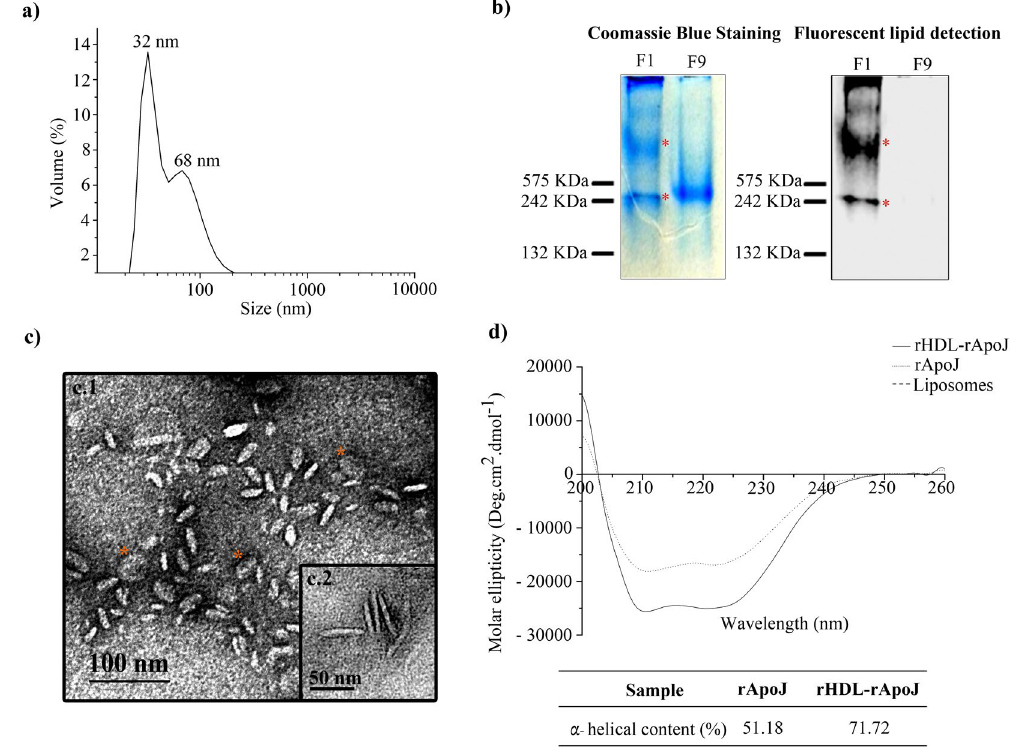
Figure 3. rHDL-rApoJ characterization. ( a ) Particle-size analysis by DLS showing the particle size after purification. (b) Native-PAGE analysis: Left panel; Coomassie Blue Staining, and, right panel; phospholipid fluorescence detection using the ODYSSEY imager. F1 refers to the first fraction of the purification step and corresponds to the purified rHDL-rApoJ nanodiscs. F9 refers to the ninth and last fraction of the purification step and corresponds to the discarded non-lipidated rApoJ. (c) Representative images of TEM showing two size populations of rHDL-rApoJ (F1) with a diameter of 24 ± 5 nm (C1) and 48 ± 2 nm (C2) both with 5 ± 1 nm of height. Orange stars indicate the face-on view of rHDL-rApoJ nanodiscs. (d) Circular Dichroism plot showing the non-lipidated rApoJ (dotted line), rHDL-rApoJ nanodisc (solid line) and the liposome (dashed line) spectra and the corresponding α -helical content calculation (%). Liposome ellipticity resulted 0 coinciding with the